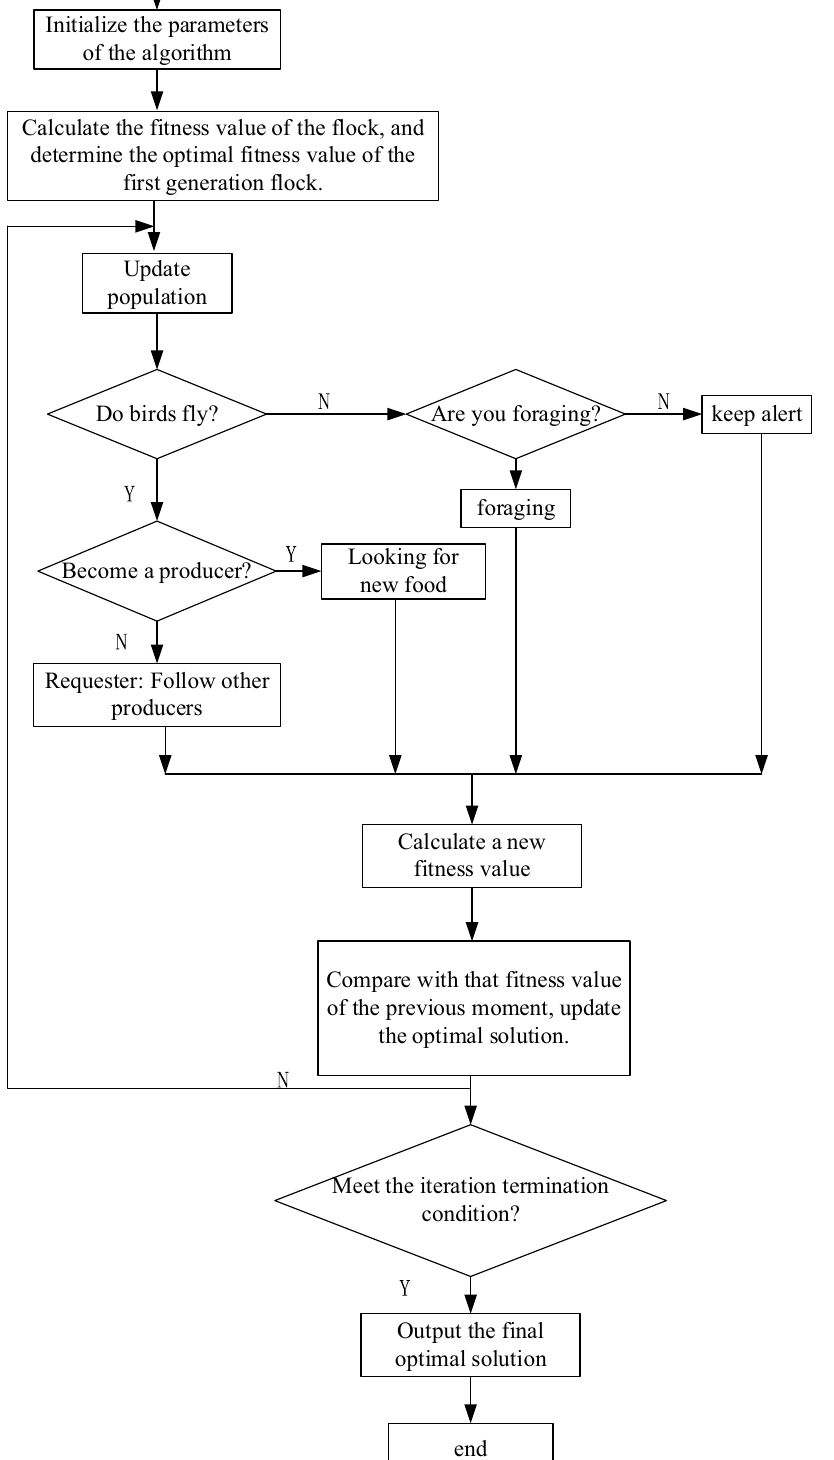
Figure 12. Flow chart of bird swarm optimization